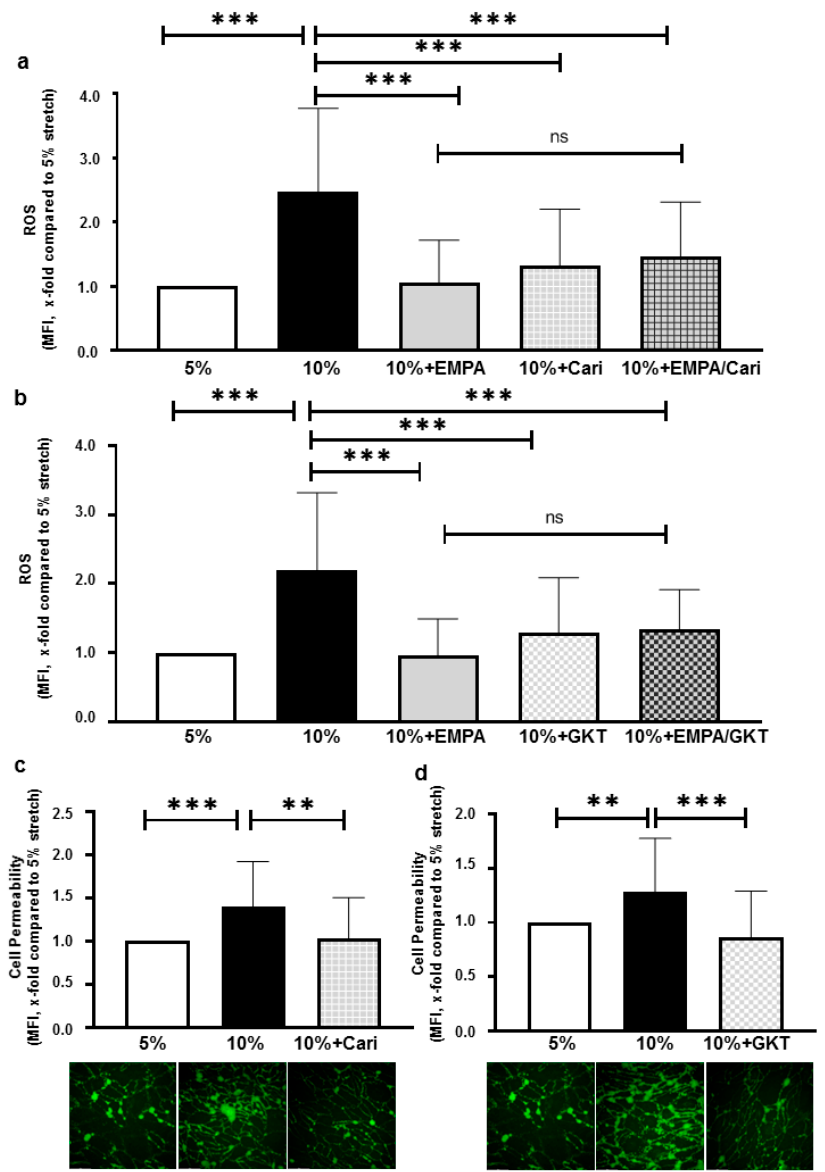
Figure 4. ROS inhibition by SGLT-2i’s might be mediated through inhibition of NHE1 and NOXs. ROS levels were measured in cells treated with 5%. stretch, 10% stretch plus vehicle, 1 µM EMPA, 10 µM cariporide/1 µM GKT136901 and combination of EMPA and cariporide/GKT136901 ( a , b ). Six images were taken from each individual experiment ( a ) n = 5 individual experiments; ( b ) n = 5 individual experiments. Cell permeability was measured in HCAECs treated with 5% stretch plus vehicle, 10% stretch plus either vehicle, 10 µM cariporide or 1 µM GKT136901 ( c , d ). Six images of each condition were taken from each individual experiment ( c , n = 5 individual experiments; ( d ) n = 5 individual experiments. Representative images are shown in the lower panels and data are presented as mean ± SD. ** p < 0.01 vs. 10%+Vehicle, *** p < 0.001 vs. 10%+Vehicle. ns: not